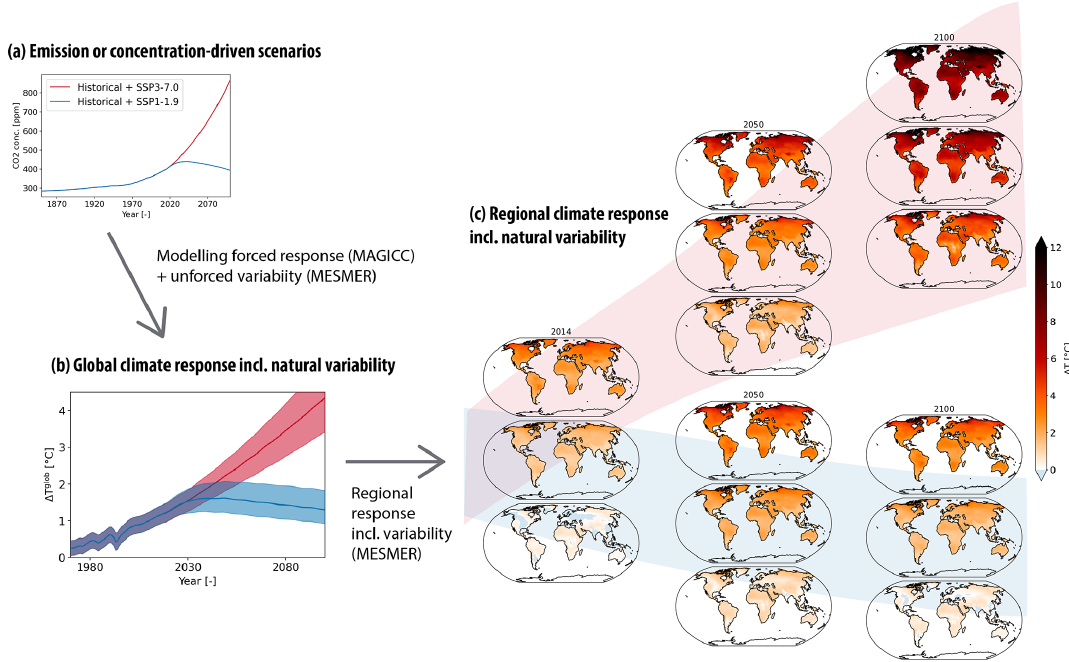
Figure 1. Illustration of the MAGICC–MESMER emulator chain. The sequence of the analysis starts from either an emission or a concentra- tion scenario, as highlighted in panel (a) for the CO 2 concentration time series of the historical time period and two Shared Socioeconomic Pathway (SSP) scenarios (O’Neill et al., 2017), namely SSP1-1.9 and SSP3-7.0. The probabilistic global mean temperature change distribu- tions – whose medians and 90% ranges (5th–95th percentile) are shown in panel (b) – consist of realizations that are a combination of the scenario-specific forced global warming from MAGICC and emulated global natural variability from MESMER. Based on this information, MESMER can derive the associated spatially resolved temperature change distributions, with the maps shown in panel (c) representing the 5th percentile, the median, and the 95th percentile (each map trio from bottom to top) for 2014 (first column of maps), for 2050 for both SSP scenarios (second column of maps), and for 2100 for both SSP scenarios (third column of